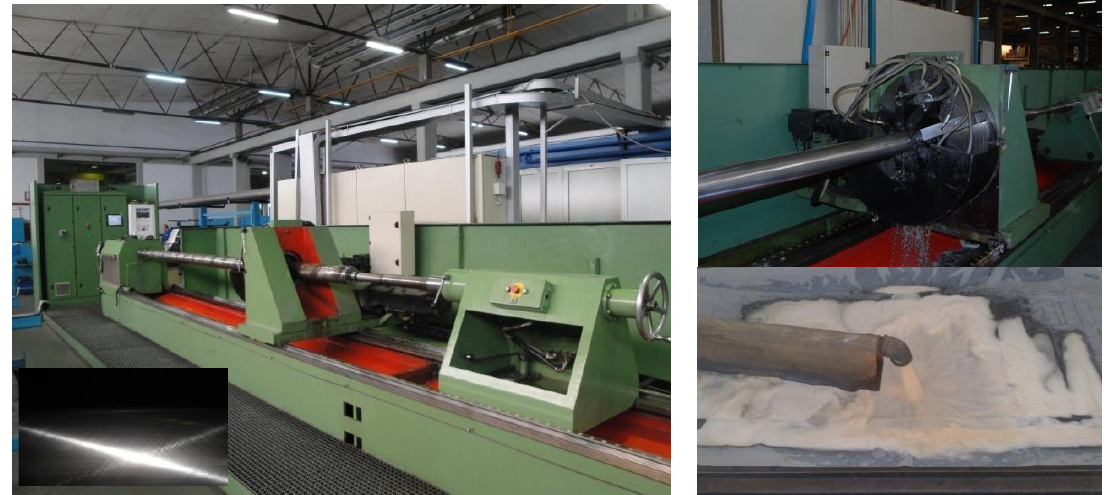
Figure 1. A Honnen metal polishing machine (the inset demonstrates a typical required quality of the produced metal surfaces with special line features on it.) Detail of the polishing head with the presence of coolant flow. Coolant’s exit from the grinding machine and detail of coolants’ initial filtering and transient temporary storage at the tanks.